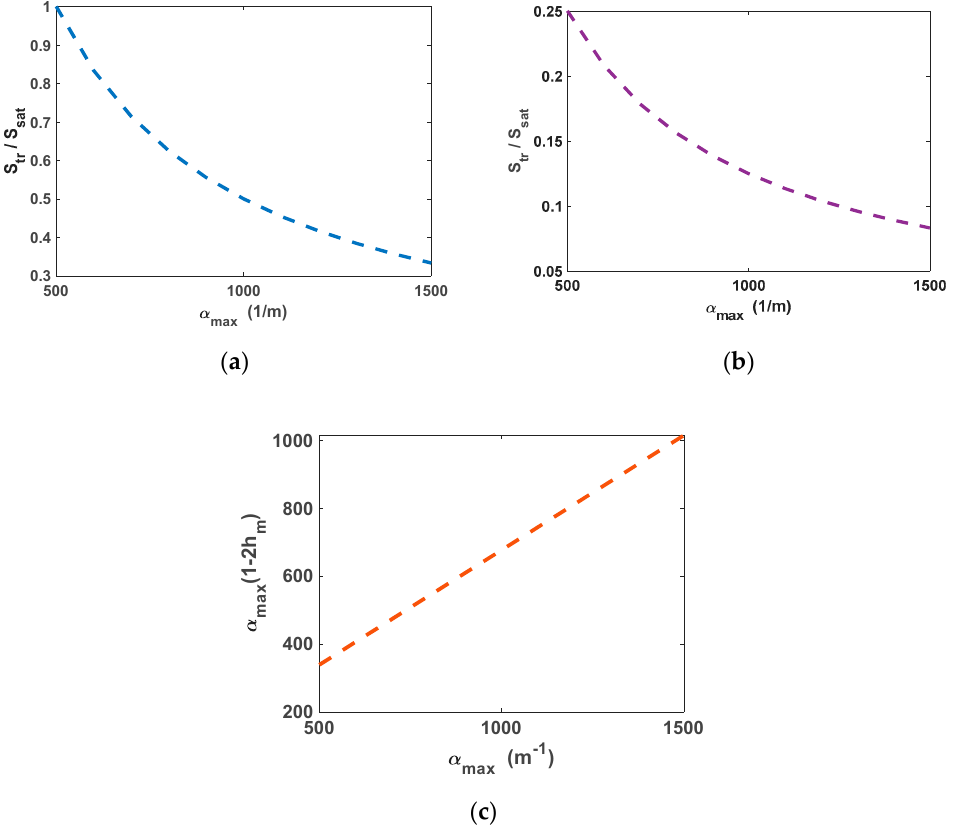
Figure 4. ( a ) Normalized transparency current for the EP QD-RSOA. ( b ) Normalized transparency power for the OP QD-RSOA.